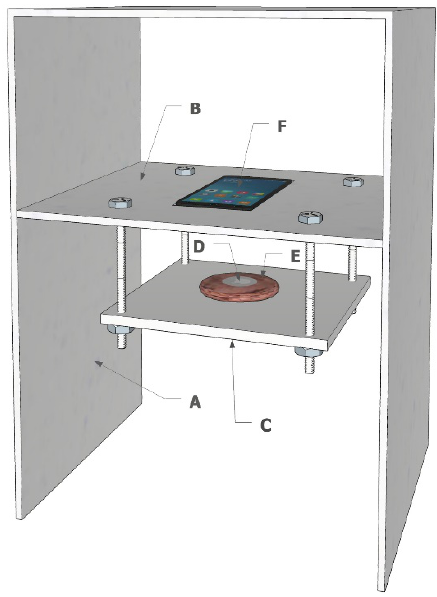
Figure 3. HF test bench: ( A ) low-density polystyrene structure, ( B ) central fixed shelf, ( C ) adjustable platform, ( D ) NFC tag, ( E ) meat sample and ( F ) Android smartphone embedding the NFC reader.